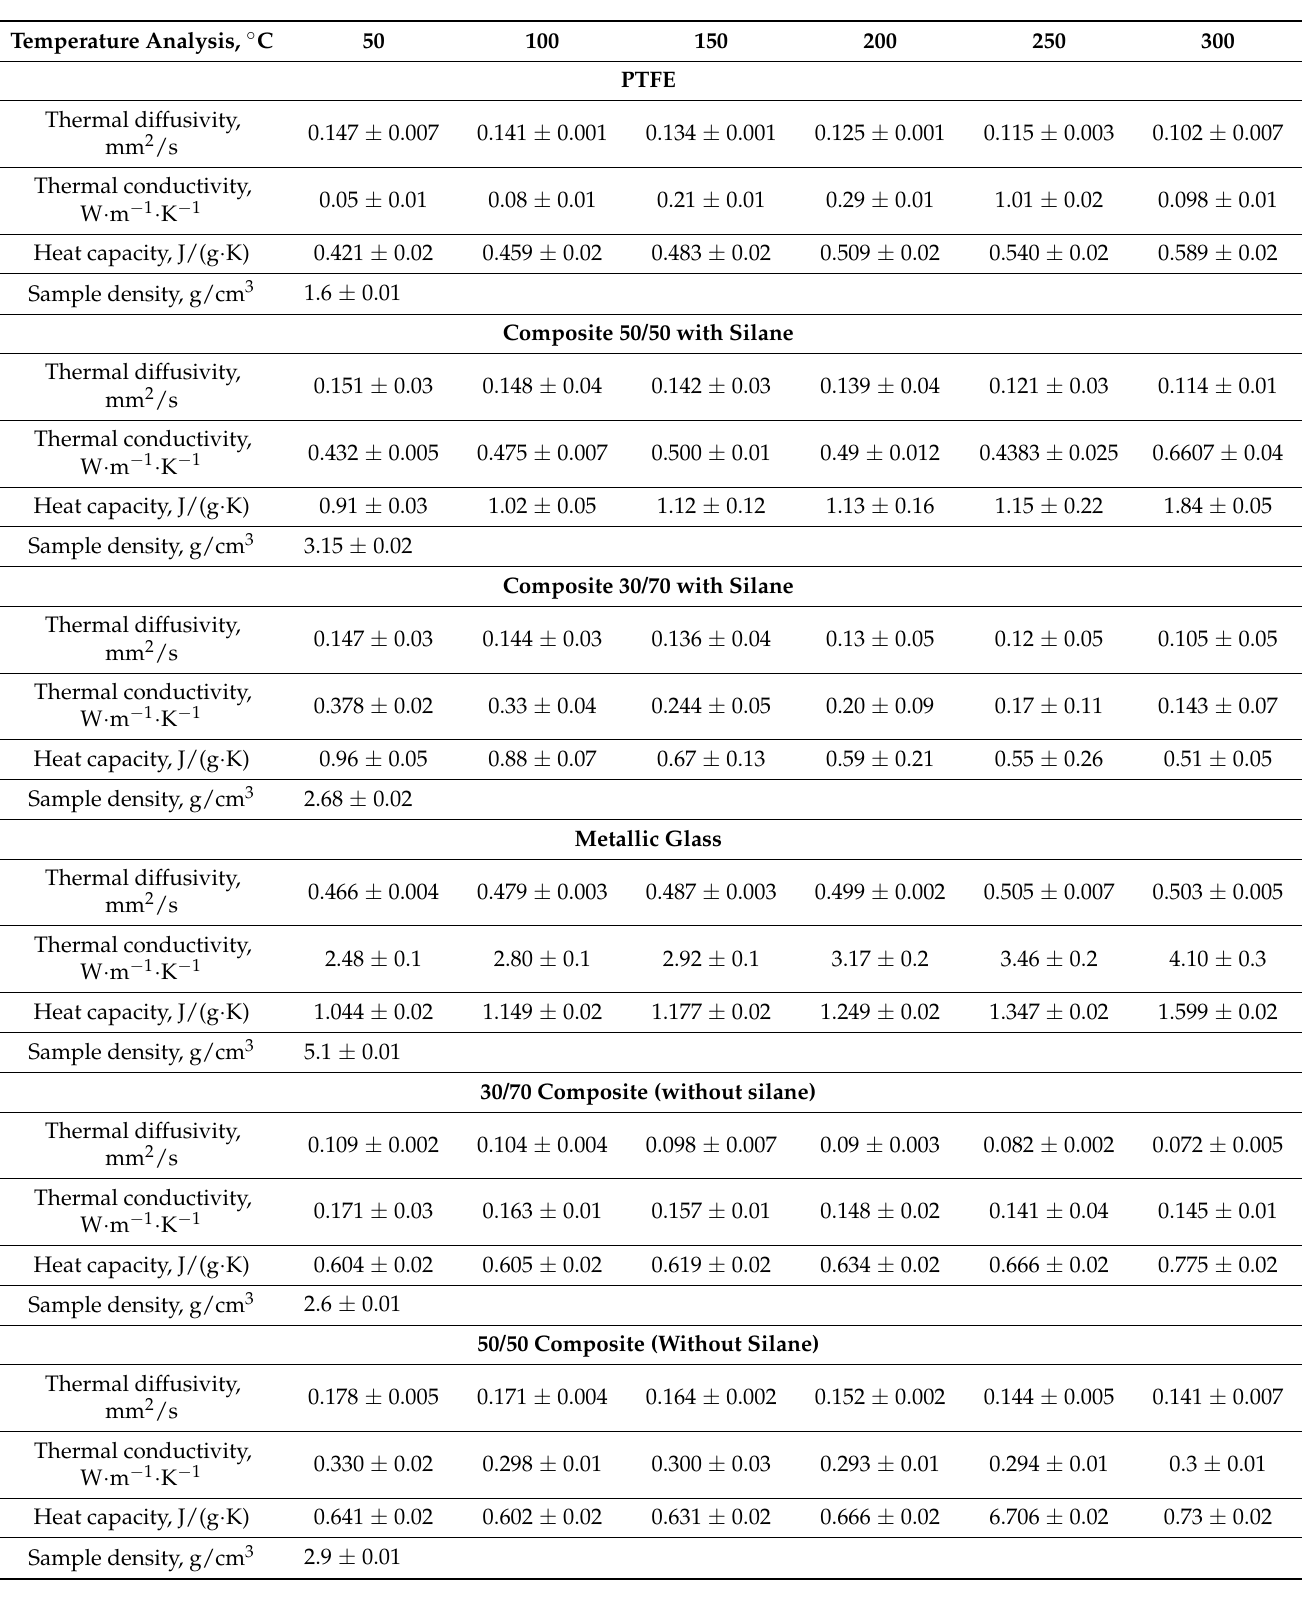
Table 1. Thermal properties of the